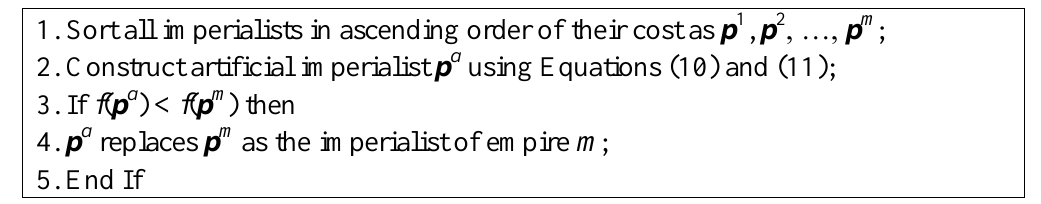
Figure 3. Interaction using Artificial Imperialist.